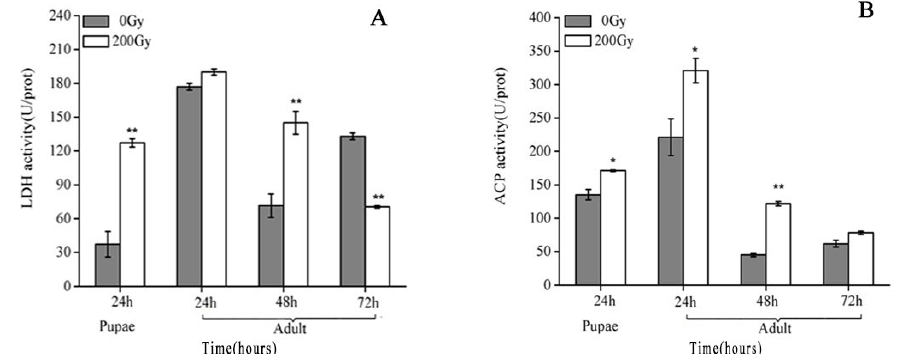
Figure 3. Effects of 60 Co- γ irradiation on activity of ( A ) LDH and ( B ) ACP in Plutella xylostella testis. Values are the mean ± SD ( n = 3). Asterisk designates statistically significant difference between control and irradiated males. (** p < 0.01; * p < 0.05).